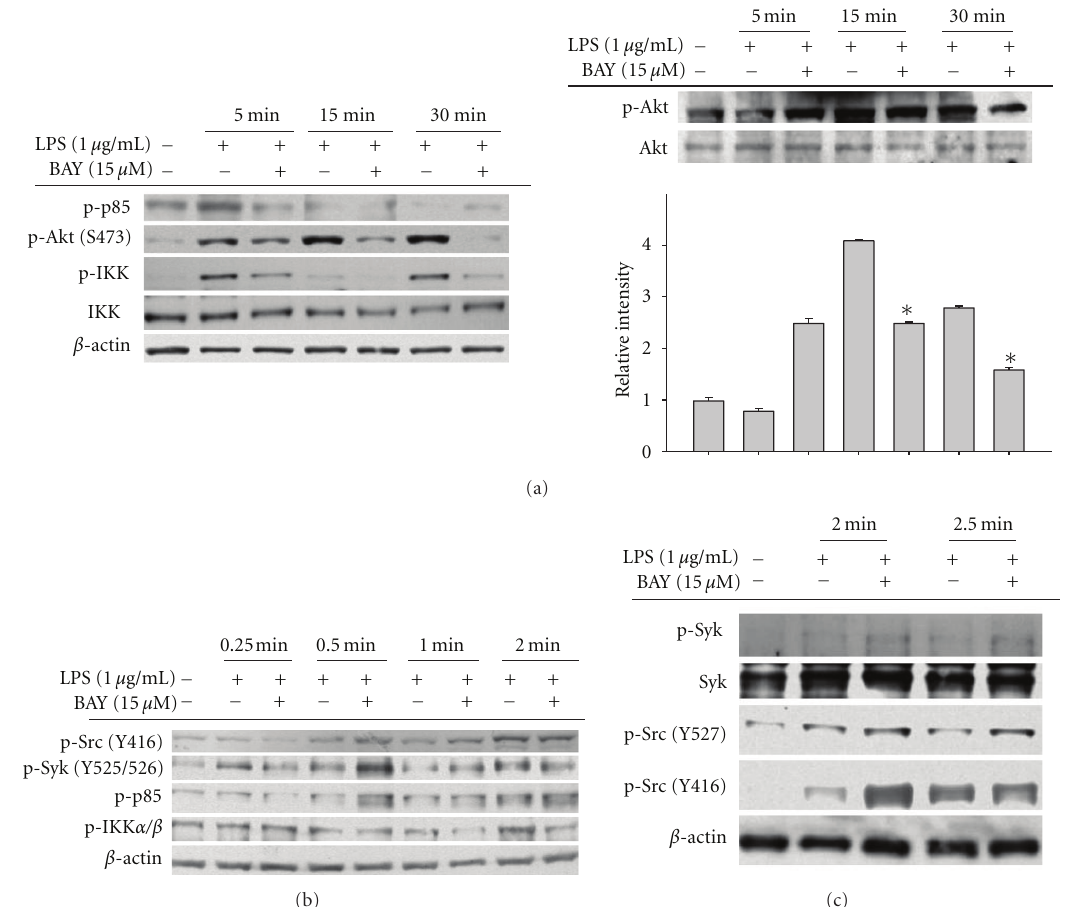
Figure 3: E ff ect of BAY on the activation of upstream signaling for NF- κ B translocation. (a to c) RAW264.7 cells (a left panel, b, and c) or peritoneal macrophages (a right panel) (5 × 10 6 cells/mL) were incubated with BAY (15 μ M) in the presence or absence of LPS (1 μ g/mL) for indicated times. After preparing whole lysates, levels of phospho (p)- or total proteins of I κ B α , IKK α / β , Akt, p85/PI3K, Syk, and Src were identified by immunoprecipitation. Relative intensity (a right panel) was calculated by densitometric